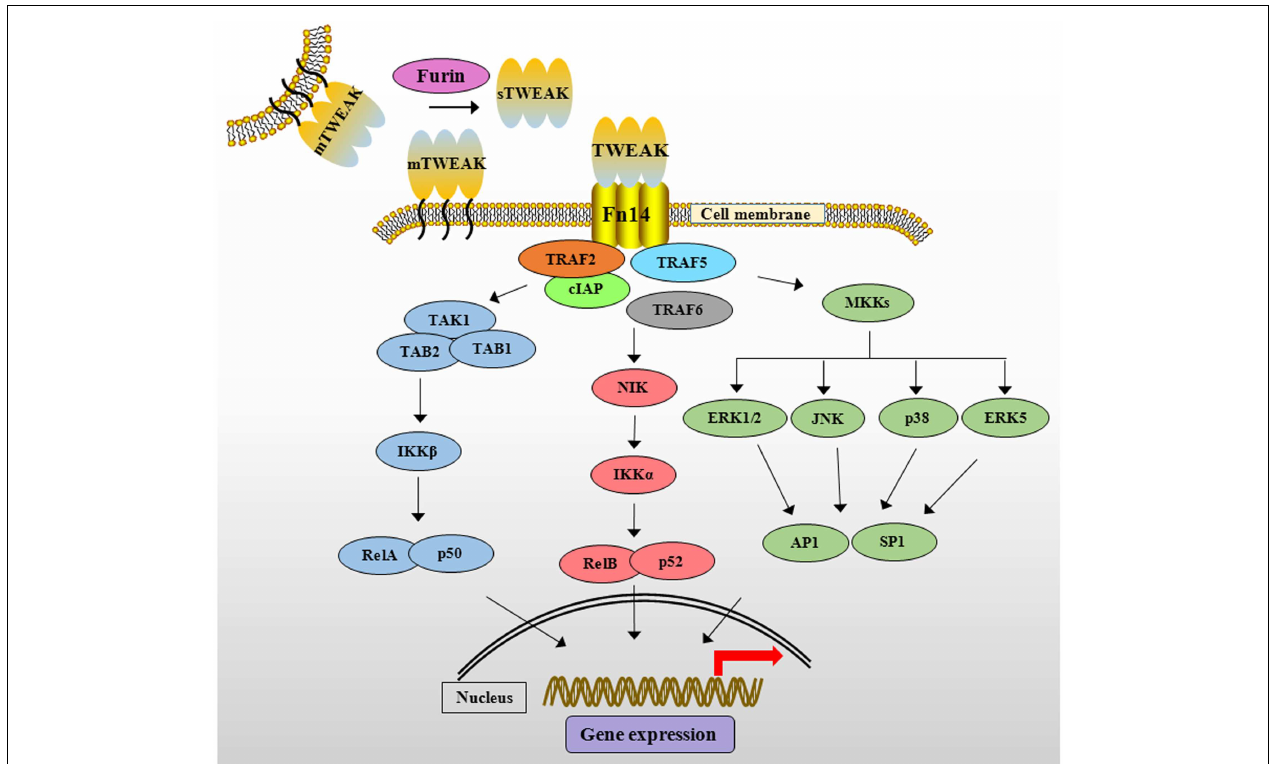
which phosphorylate ERK1/2, ERK5, JNK, and p38MAPK resulting in the activation of downstream transcription factors such as AP1 and SP1. TWEAK,TNF-like weak inducer of apoptosis; Fn14, fibroblast growth factor inducible 14; cIAP, cellular inhibitor of apoptosis;TRAF,TNF receptor-associated factor;TAK1, transforming growth factor β -activated kinase 1,TAB,TAK1 binding protein; IKK, I κ B kinase β ; I κ B, inhibitor of nuclear factor of kappa B; NIK, NF- κ B-inducing kinase; MAPK, mitogen-activated protein kinase; MKKs, mitogen-activated protein kinase kinases; ERK, extracellular signal-regulating kinase; JNK, c-Jun N-terminal kinase; AP1, activator protein 1; SP1, specificity protein